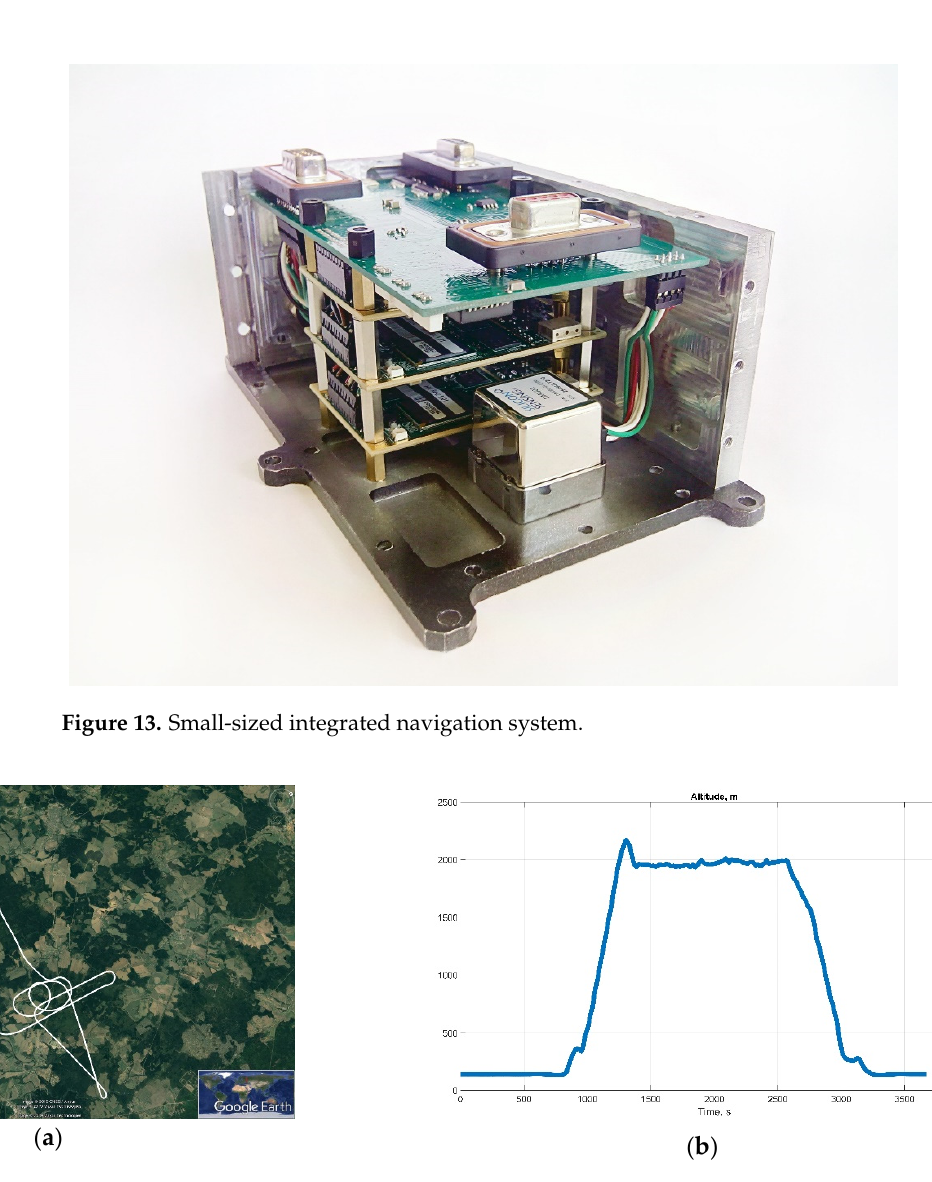
Figure 14. Helicopter test track: ( a ) horizontal track; and ( b ) altitude.